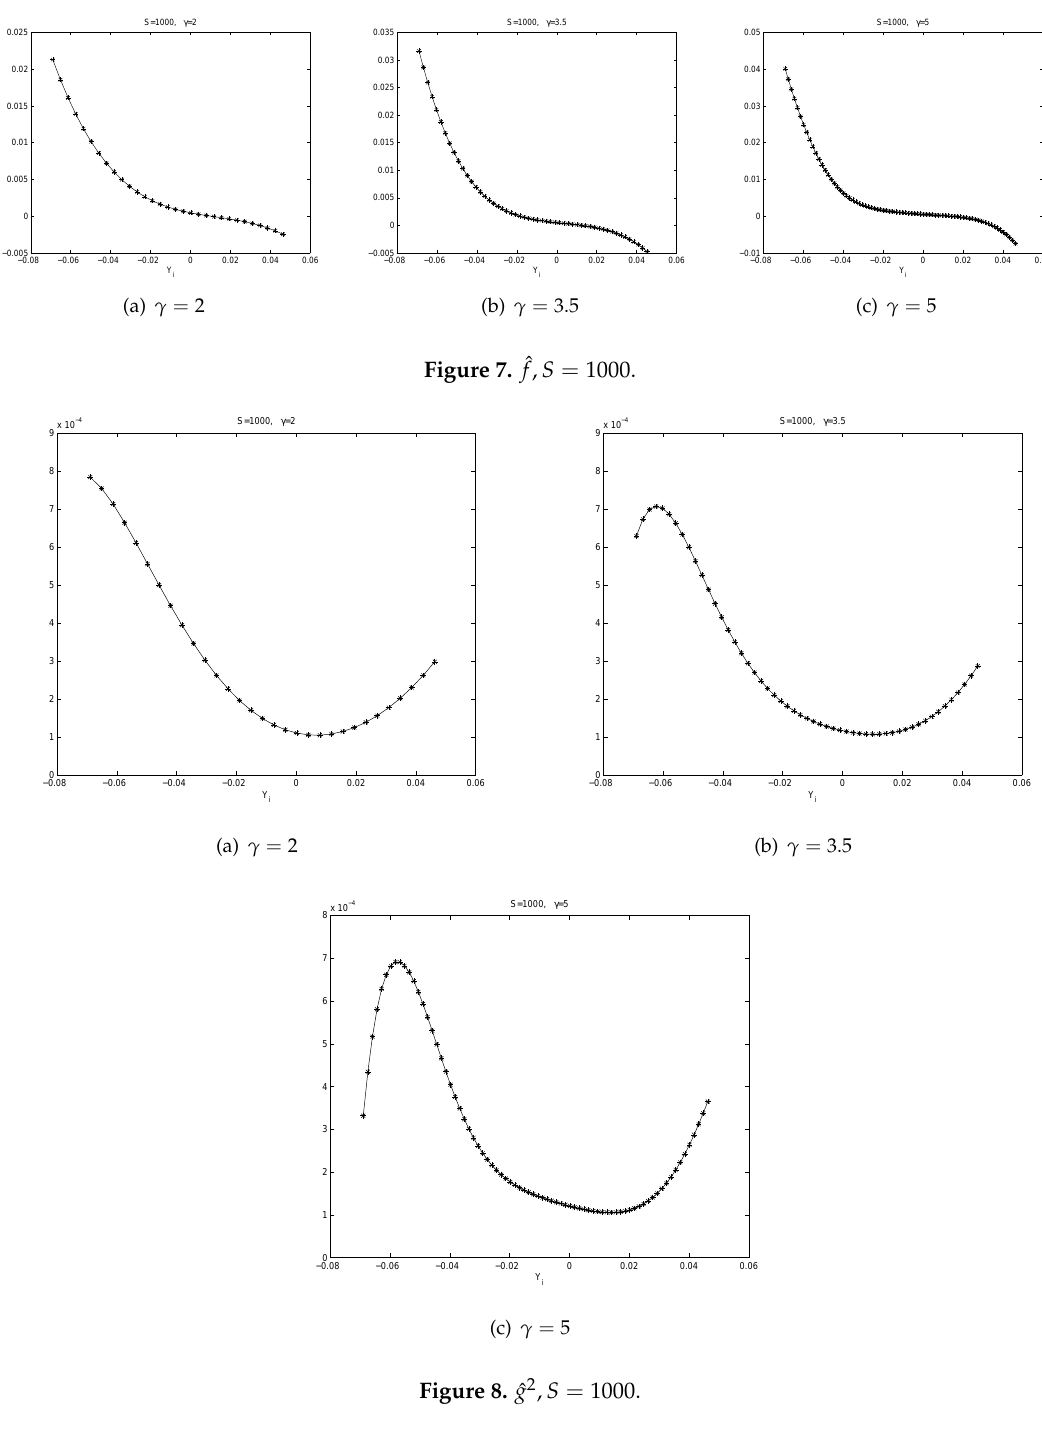
Figure 8. ˆ g 2 , S =